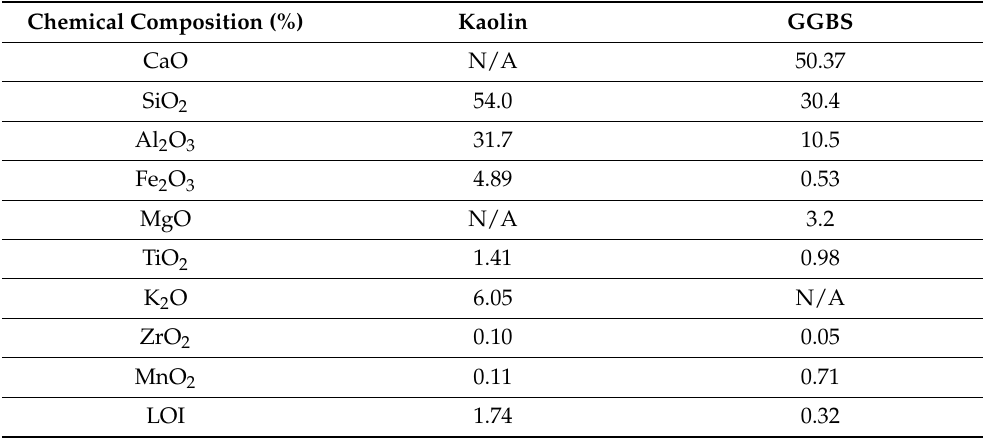
Table 1. Chemical composition of kaolin and